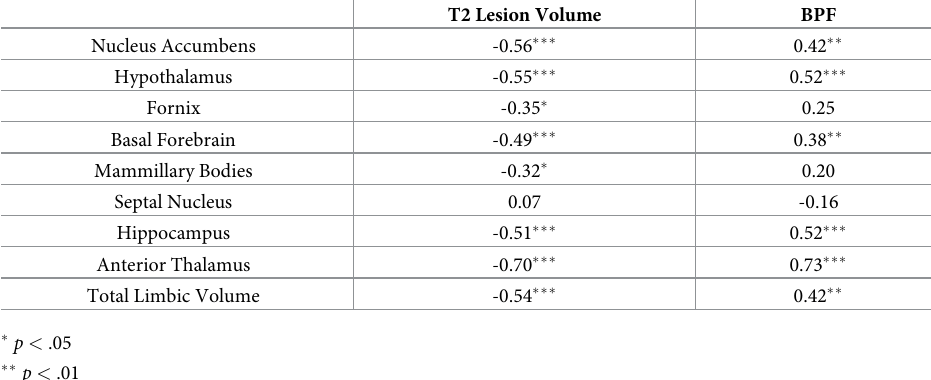
Table 2. Spearman correlation coefficients between T2 Lesion volume or BPF and individual limbic regions or the total area.